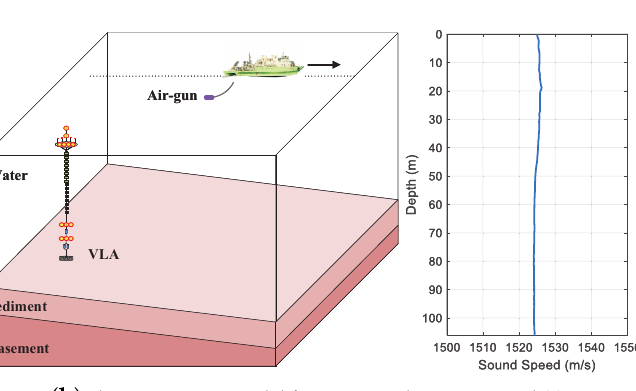
( a ) The bathymetry of experiment area.